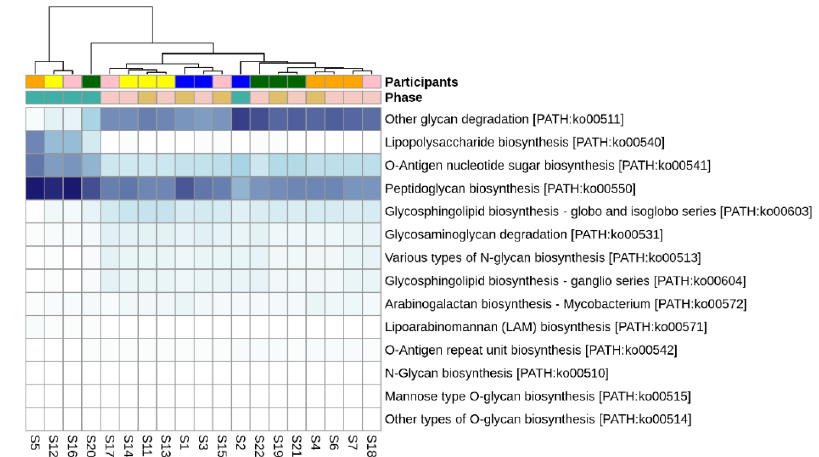
Figure 7. Differentially abundant Tier 3 KEGG pathways before, during, and after disruptive norovirus-associated AGE. Those within the Tier 2 KEGG pathways of ( a ) Carbohydrate metabolism, and ( b ) Glycan biosynthesis are shown. The first-row color scale indicates the participant numbers. The second row shows the phase of sample collection; before, during, or after AGE. Numbers following “S” indicate the sample identifier for metagenomic data. Note that for Participant A and for the second norovirus infection of Participant B, the microbiomes during norovirus-associated AGE are grouped with the ‘before’ and ‘after’ infection microbiomes of all children, including their own.